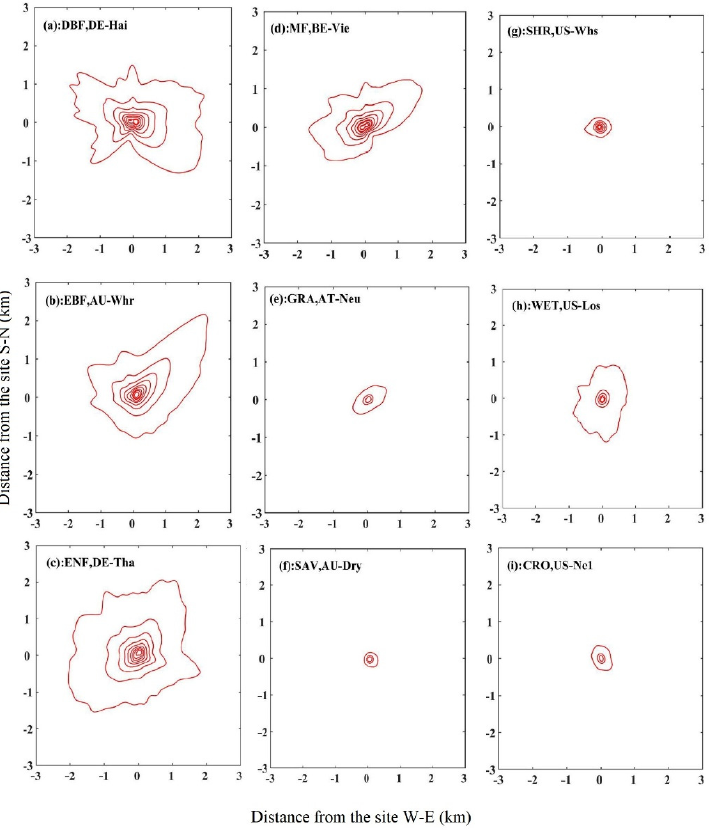
Figure 2. The contours of cumulative footprint climatology for a 16-day time step at 10 sites, representing each vegetation type. The sites (DE-Hai to US-Ne1) are given in Figure 3a. The biome types are as follows: ( a ) deciduous broadleaf forest (DBF); ( b ) evergreen broadleaf forest (EBF); ( c ) evergreen needleleaf forest (ENF); ( d ) mixed forest (MF); ( e ) grasslands (GRA); ( f ) savannas (SAV); ( g ) shrublands (SHR); ( h ) wetlands (WET); ( i ) croplands